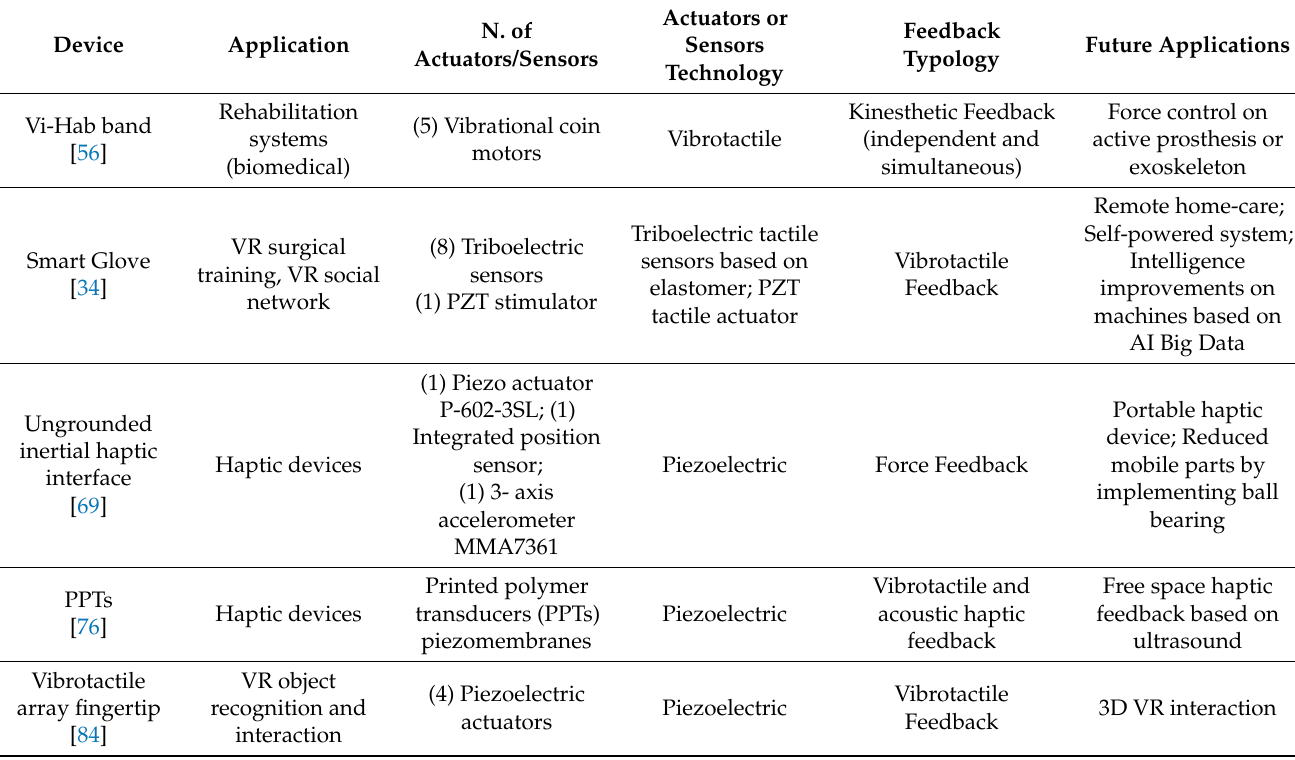
Table 2. Characteristics and technical specifications of all the analyzed